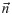
The plane of arbitrary normal n→ (here n→=(nx,ny,nz)=(0.841,0.480,0.249)) divides a unit voxel in two parts (red dashed line).As the plane moves in the direction of its the normal, the area of intersection varies, as indicated by the blue curve. The volume within the voxel on the left side of the plane is indicated by the cumulative volume and represented by the purple curve.